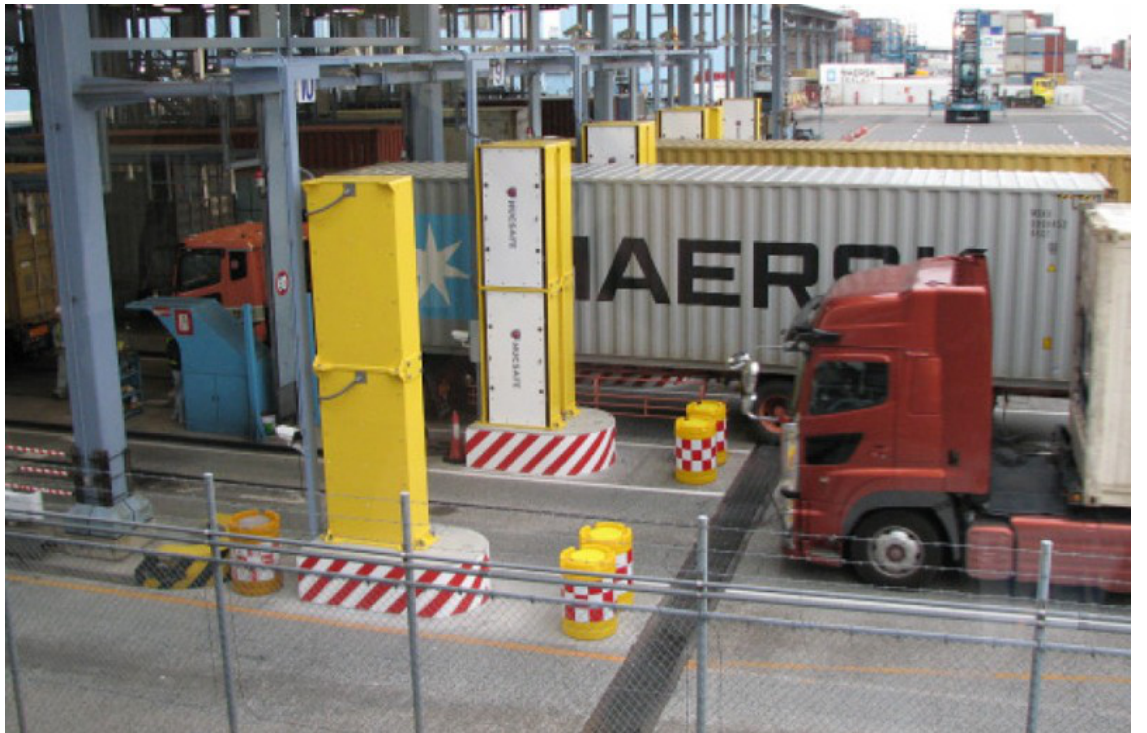
Figure 5. Shipping containers driven on flatbed trucks through vertical radiation portal monitors (white panels in yellow housing). Reprinted, with permission, from [59]. © American Science & Engineering, Inc., An OSI Systems